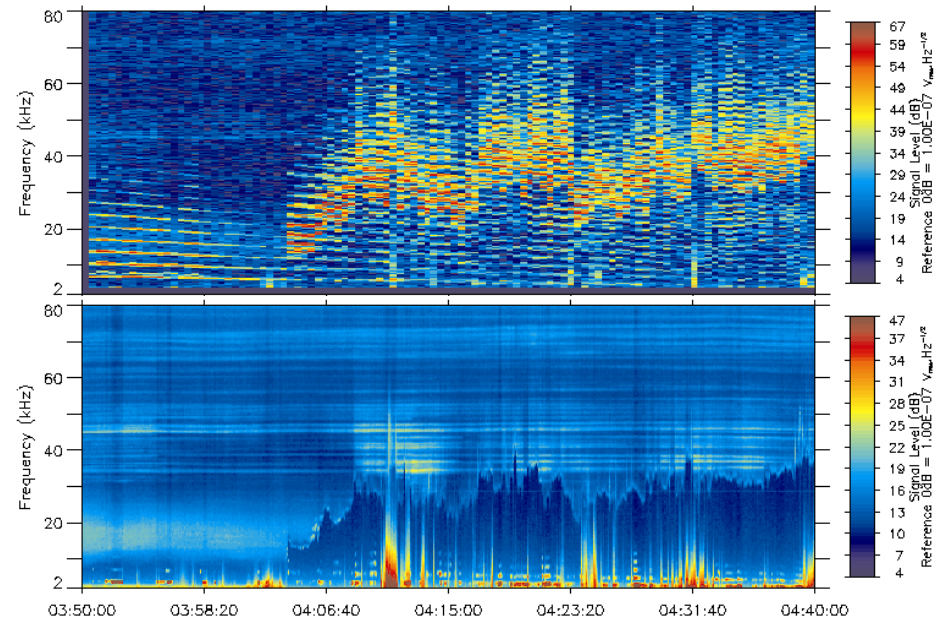
Fig. 7. Frequency/time spectrogram in Sounding only (upper panel) and Natural wave only (bottom panel) modes, derived from TANGO (spacecraft 4) data in the dayside region (11.7MLT, 81 ◦ invariant latitude, 8.1 R E ), outbound leg, on 26 Feb 2001. The sharp density increase at about 04:06UT marks the entry in a plasma cloud, left at 05:00UT, inside the magnetosphere. The magnetopause proper is crossed at